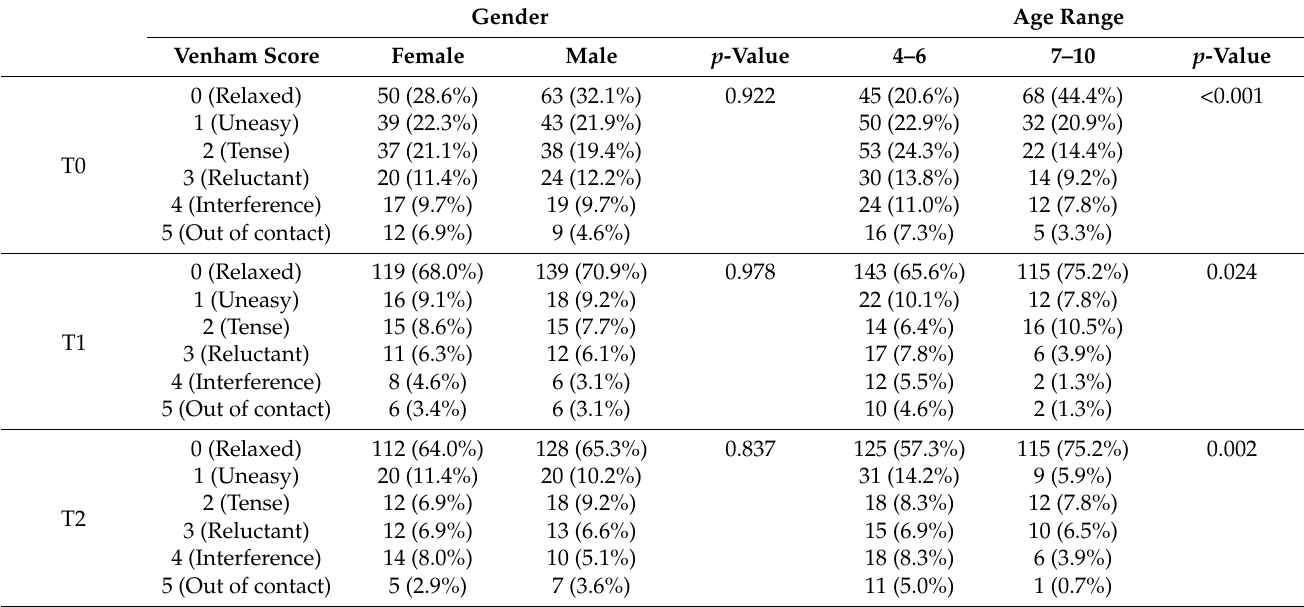
Table 4. Venham score per age range and gender.